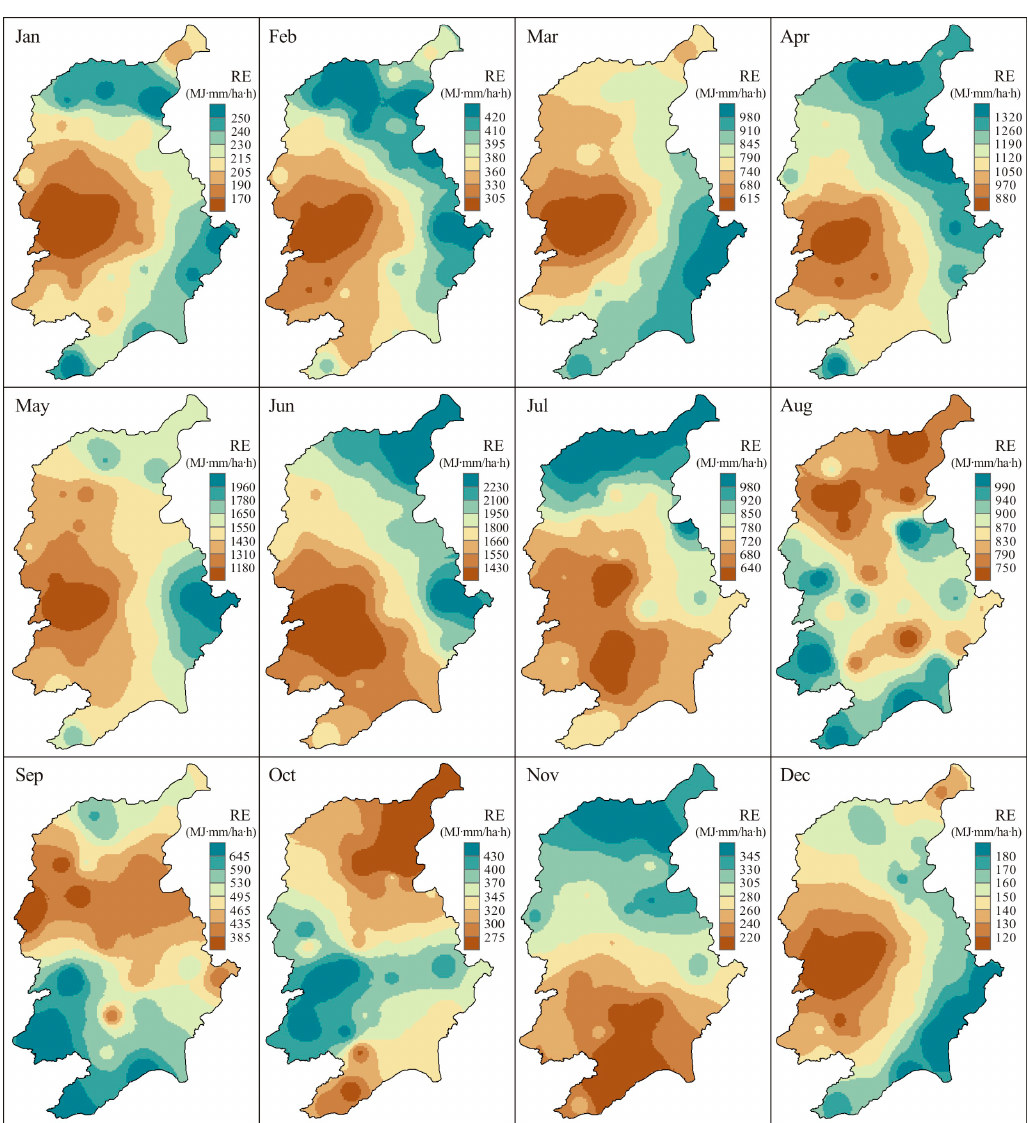
Figure 7. Spatial distribution of monthly rainfall erosivity in the Ganjiang River catchment.